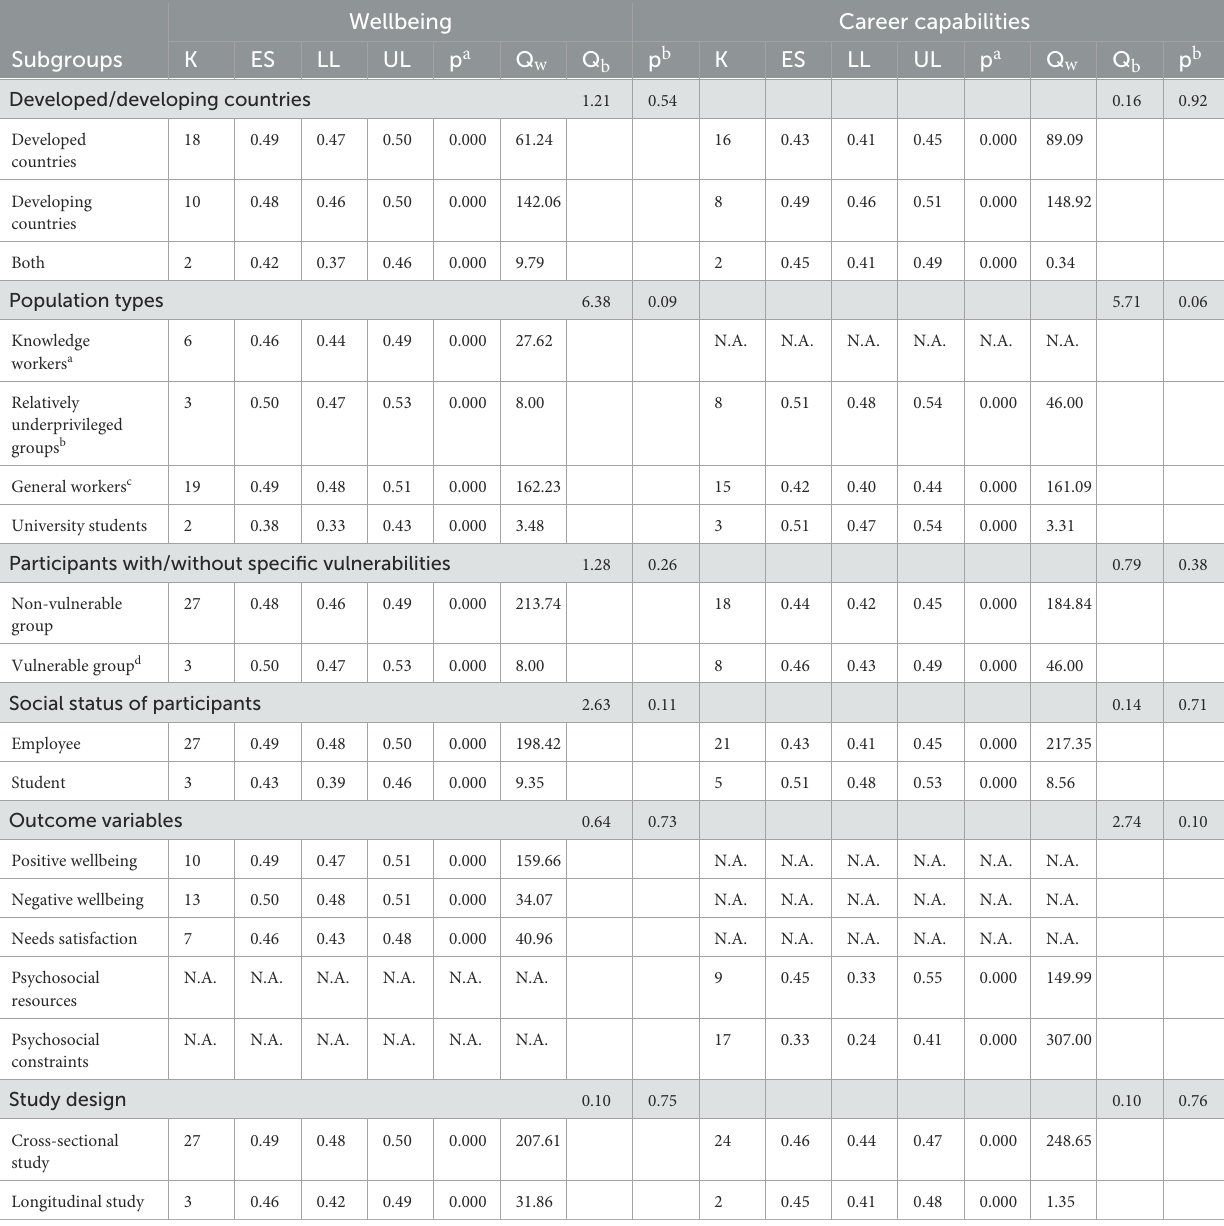
TABLE 3 Subgroup analyses for the associations of decent work with wellbeing and career capabilities. Wellbeing Career